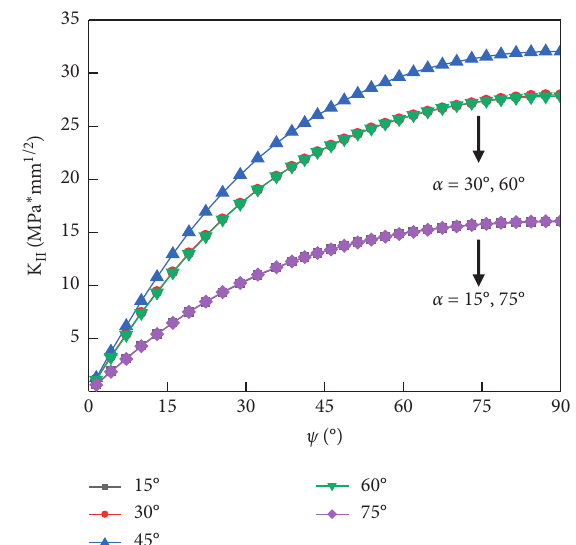
Figure 11: Numerical simulation results of K